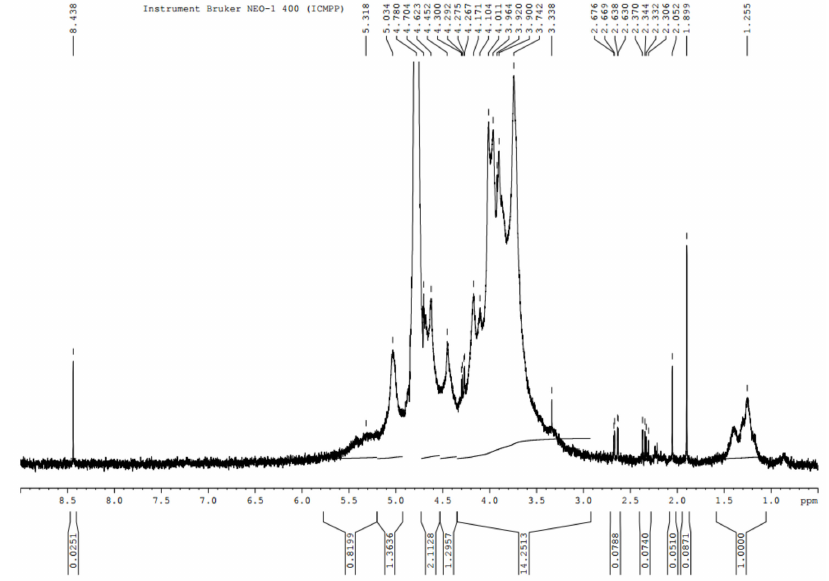
Figure 5. NMR spectrum of alginate extract separated from Fucus spiralis